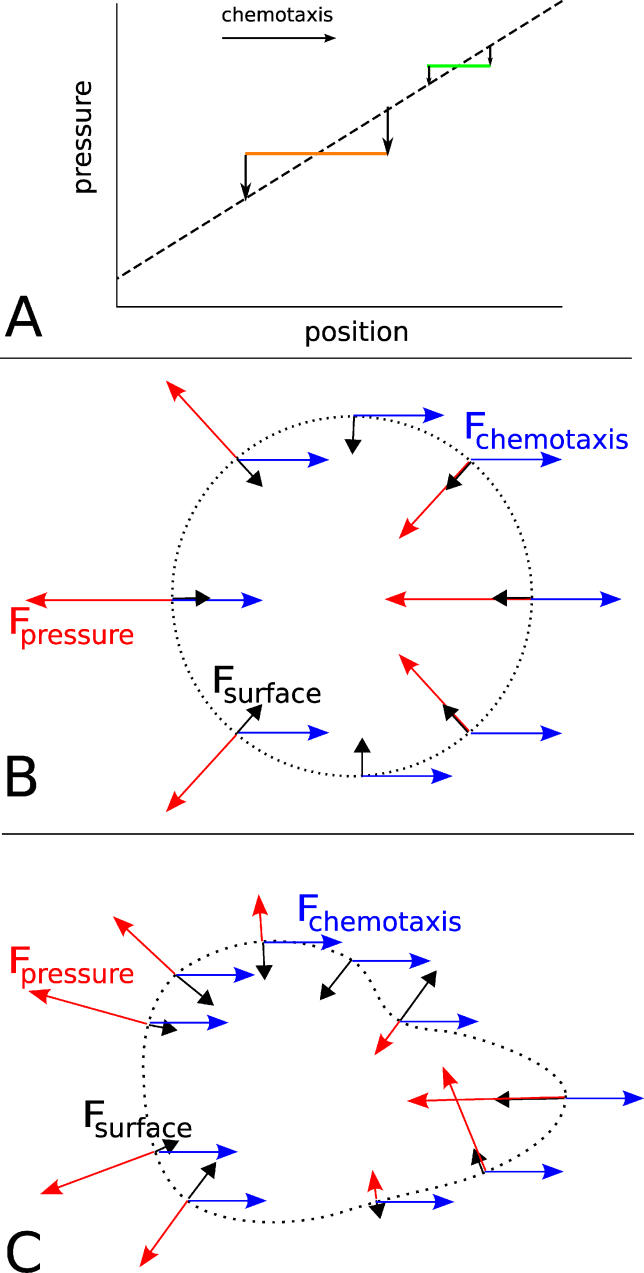
Schematic Representation of the Effect of Pressure and Chemotaxis on Cell Shape within a Confined Cell Mass(A) A small (green) and a large (orange) cell within a pressure gradient. The dashed line represents the average pressure in the overall cell mass (cf. Figure 2). Throughout each cell, however, the pressure is constant. The vertical arrows represent the pressure-driven tendency to extend into cells with a lower pressure, and therewith the tendency of each cell to move backward. At the extremities of a large cell, the pressure differences are larger than at the extremities of a small cell; therefore a large cell moves backward faster.(B) Orientation and magnitude of the forces exerted due to pressure and chemotaxis. Forces act upon the cell membrane (dotted circle). The magnitude and direction of the chemotaxis (blue arrows) is constant along the boundary. The forces due to pressure differences (red arrows) vary in magnitude and direction: large and inwards at the front, large and outwards at the back, and small in the centre. Cells tend to round up due to the surface forces (black arrows), which are determined by the shape of the cell, and limit the level of deformation. The latter forces are directed perpendicularly to the membrane, with sign and magnitude depending on the curvature.(C) A deformed cell (dotted line). The pressure (red arrows) and surface (black arrows) forces are again perpendicular to the membrane. For the surface forces, the magnitude is proportional to the curvature, so the force is directed towards the concave side. The chemotactic forces (blue arrows) remain the same. Note that the surface and pressure forces are not defined as such in the model; they arise from the minimisation of Equation 3. The chemotactic force is simply a consequence of Equation 1.